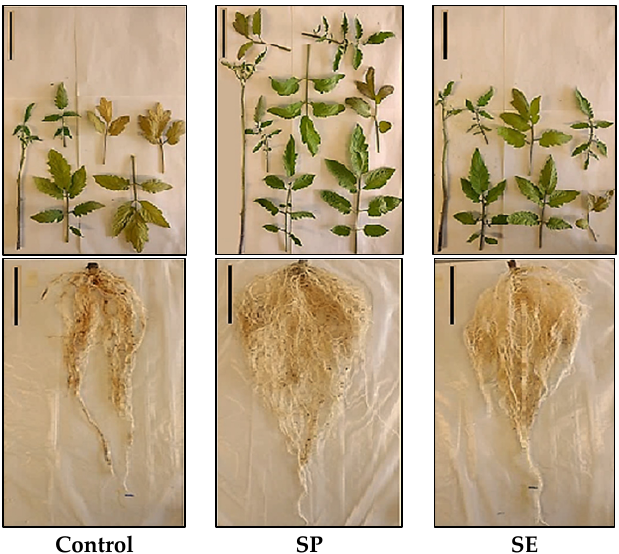
Figure 3. Tomato plant growth after the 45-day experiment. Treatments included control (untreated plants), plants treated with seaweed powder (SP) and plants irrigated with seaweed extract (SE) from Ulva ohnoi . Bar = 5 cm.